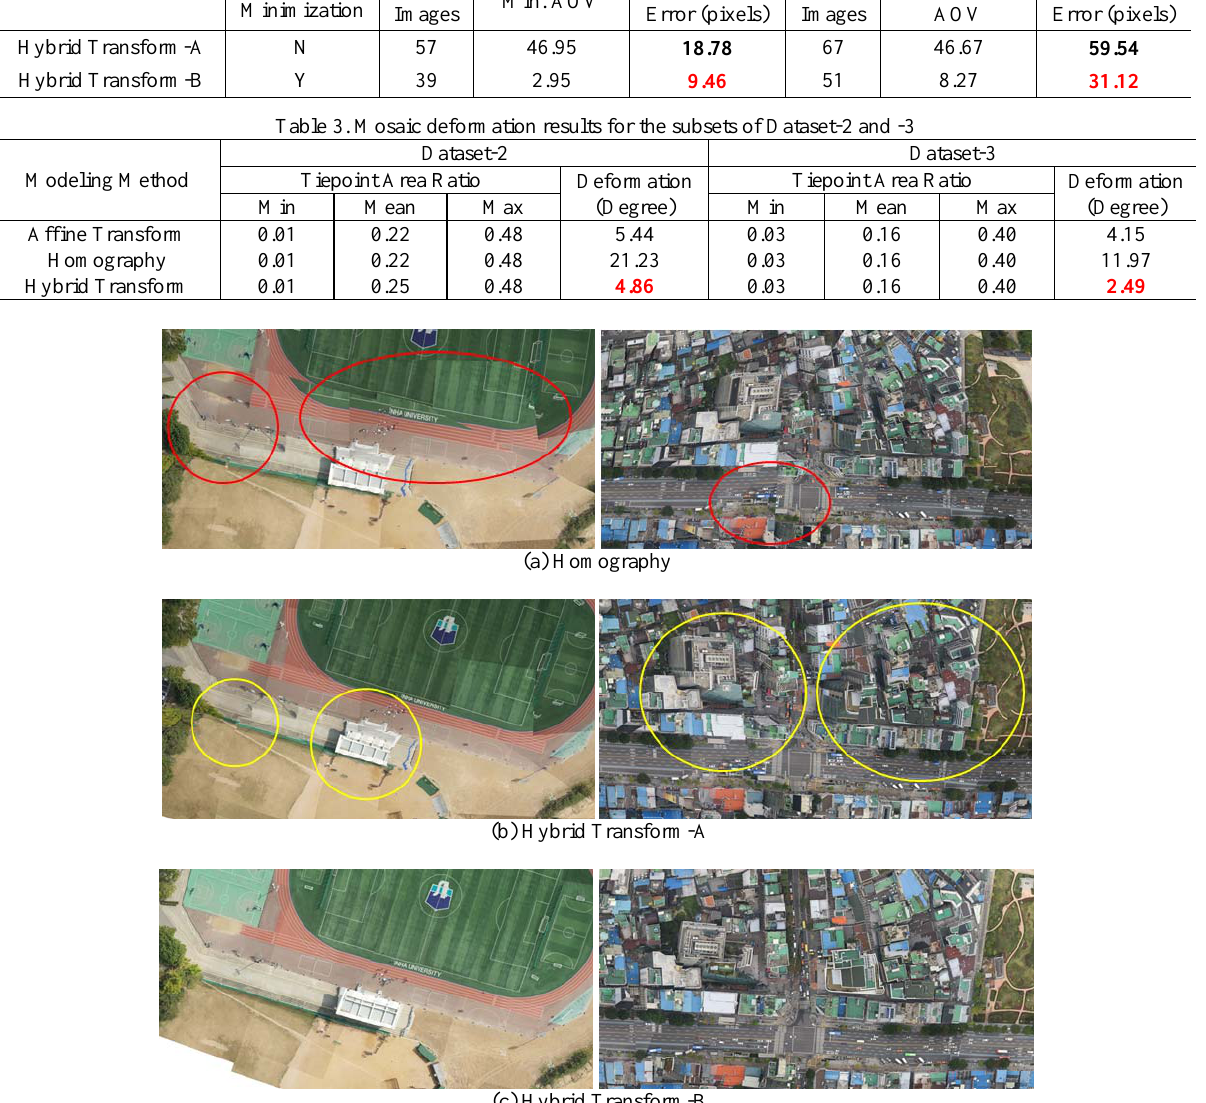
Figure 5. Mosaicking result comparison for the Dataset-2 (left column) and 3 (right column)